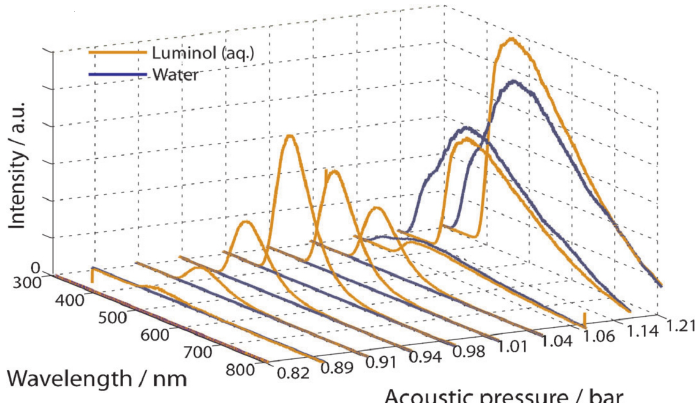
Figure 3. Single-bubble sonoluminescence emission spectra obtained in degassed water compared with the sonochemiluminescence spectra from an aqueous luminol solution. All spectra are plotted as a function of the driving acoustic pressure. Reproduced from [60] with the permission of John Wiley and Sons. Copyright 2012.